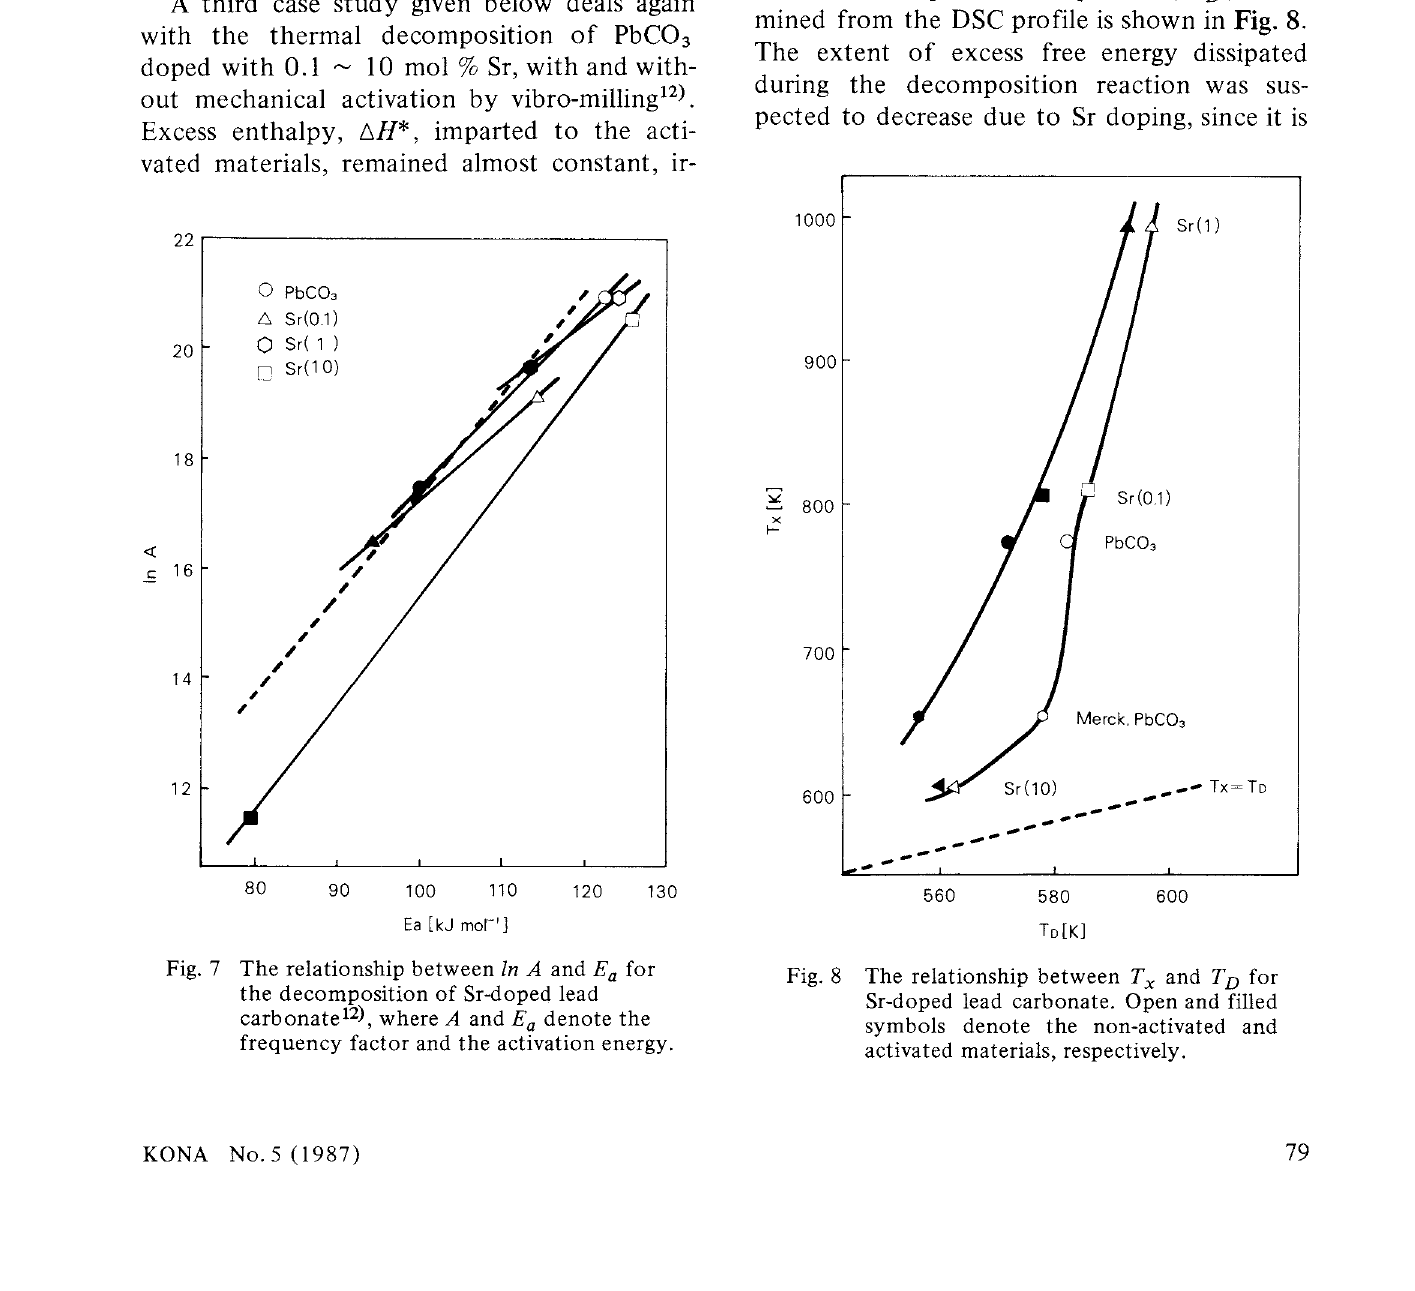
Fig. 8 The relationship between Tx and Tv for Sr-doped lead carbonate. Open and filled symbols denote the non-activated and activated rna terials,